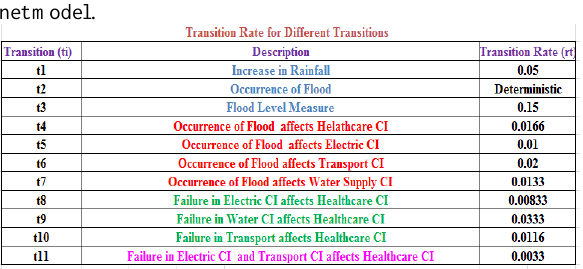
Table 1. List of Transition rate for Different Transitions.